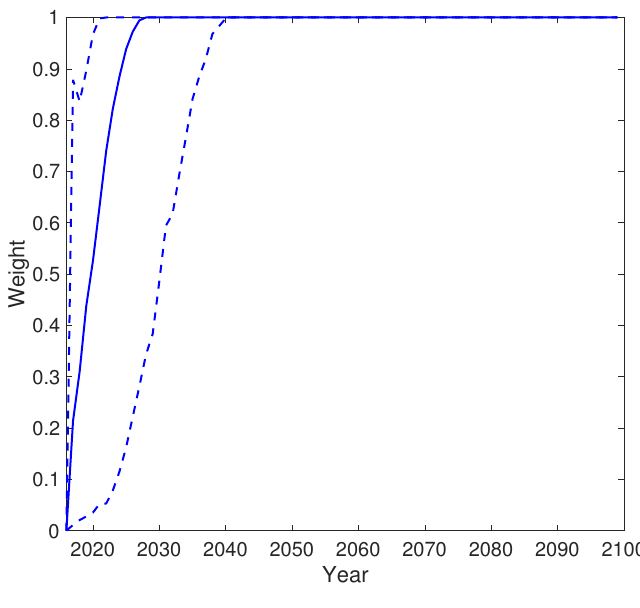
Figure A2. The 2.5%, 50%, and 97.5% quantile of the weight over time for Brazil. Figure A3 shows that the rotation for Nigeria has, on average, not yet finished by the end of the projection phase. In 2100, w s becomes 0.58 on average, and it becomes 0.8 (resp. 0.22) for the 97.5% (resp. 2.5%)